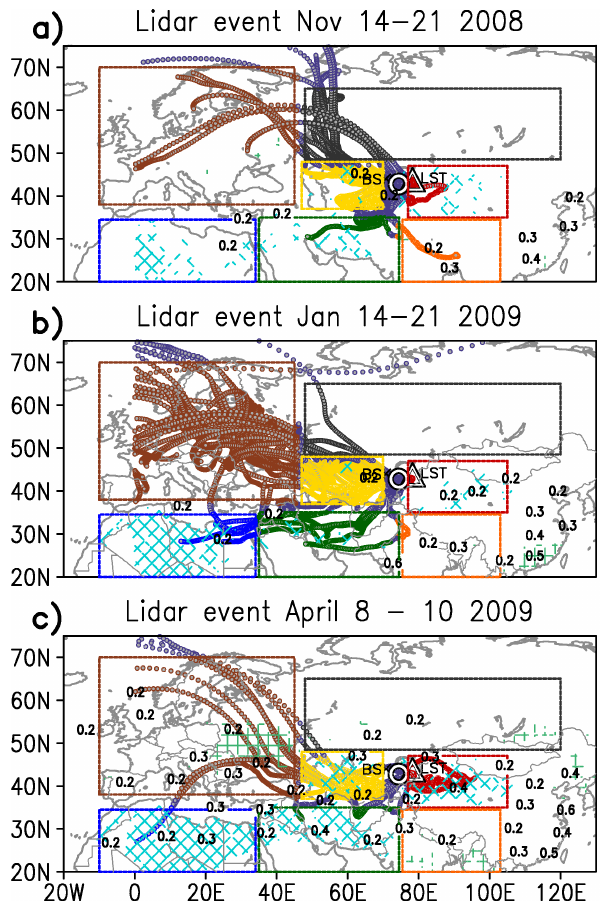
Figure 15. Same as Fig. 14 but for November 2008, January 2009, and April 2009 (events 3, 4, and 5 denoted in Fig.